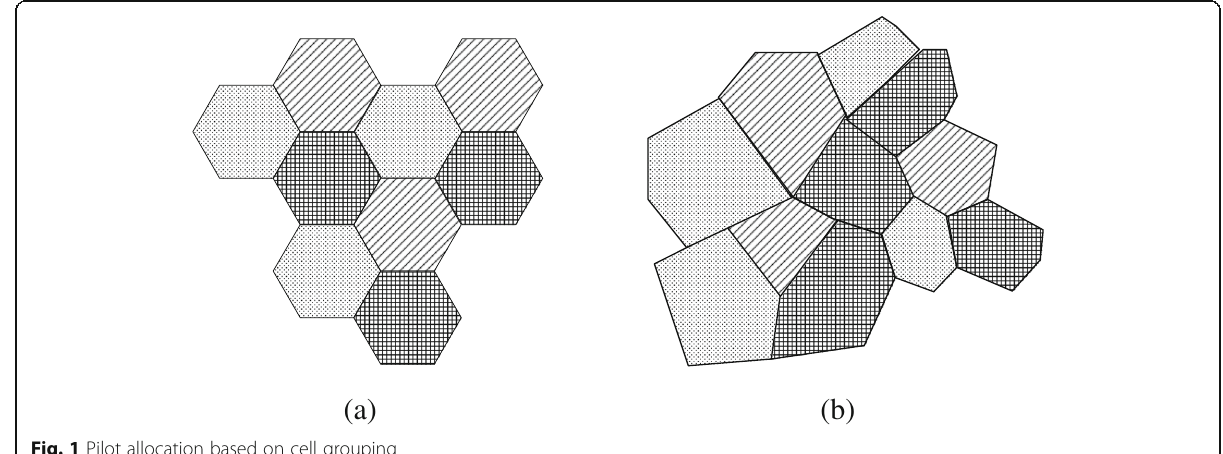
Fig. 1 Pilot allocation based on cell